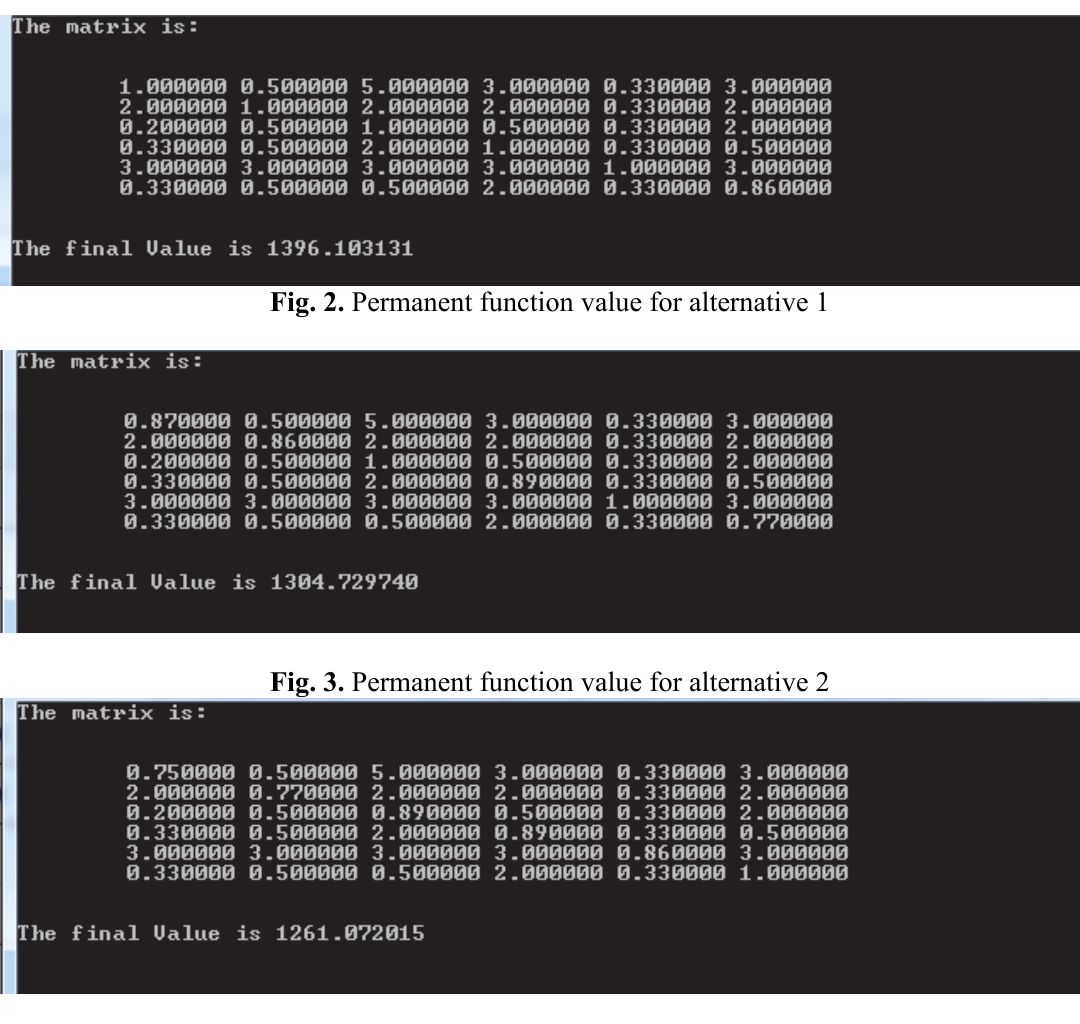
Fig. 3. Permanent function value for alternative